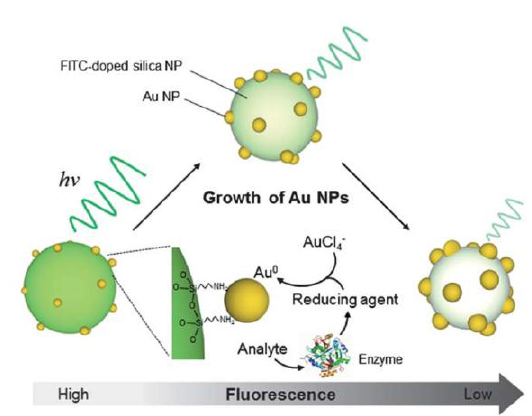
Figure 2. Schematic diagram of Au NP enlargement-based detection of target analytes using the fluorescence change of FITC-doped silica NPs. Reproduced from [13] with permission of The Royal Society of Chemistry.